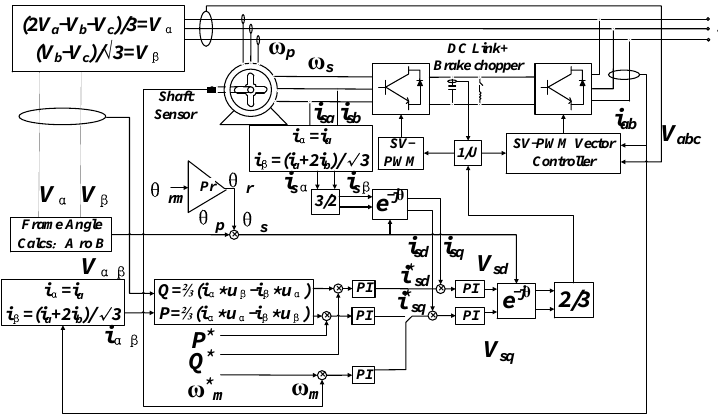
Figure 2. A structural diagram of the BDFRM (G) drive setup.